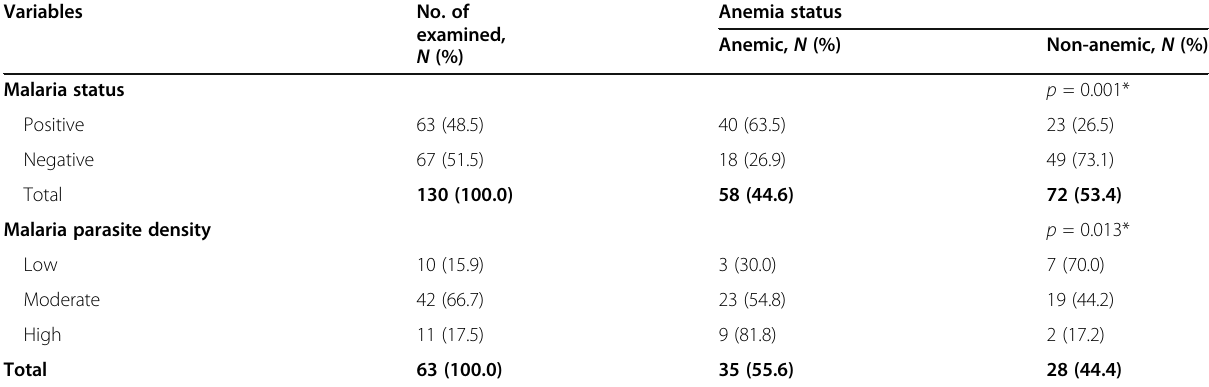
Table 2 Effect of malaria parasite infection on the prevalence of anemia among the study participants Variables